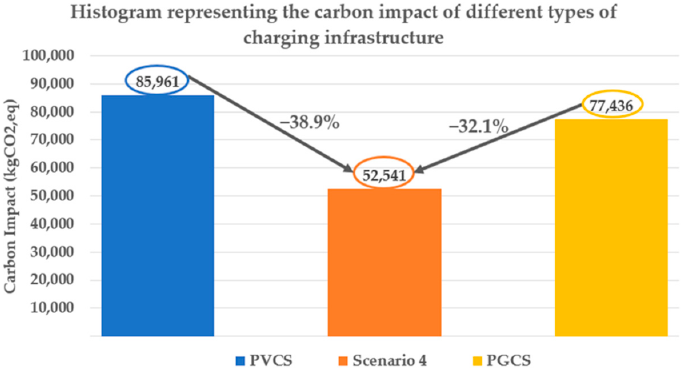
Figure 11. Result of scenario